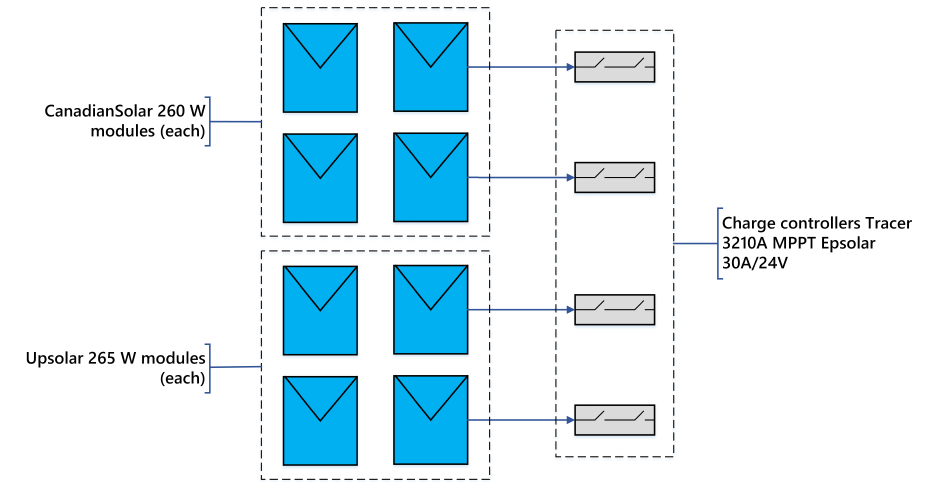
Figure 7. Arrangement of photovoltaic modules and their connections.